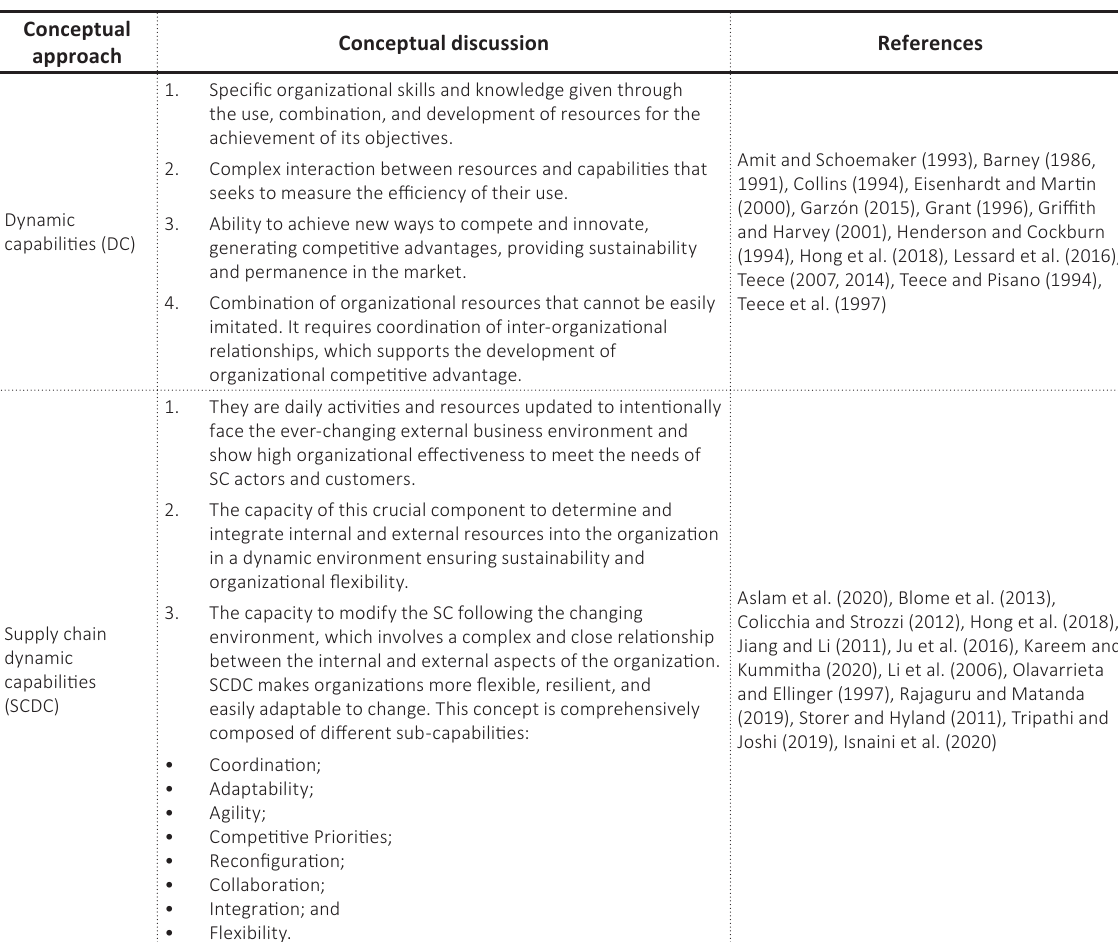
Table 1. Conceptual framework DC and